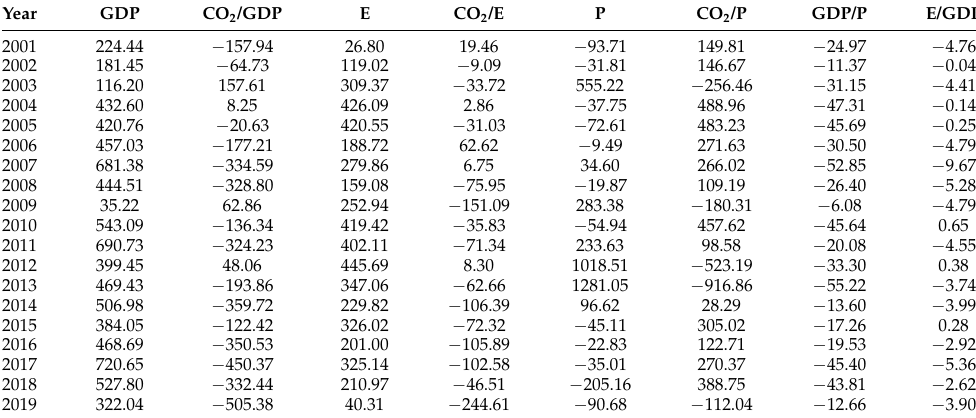
Table 5. Contribution of CO 2 emissions of each decomposition factor. Unit: 10 4